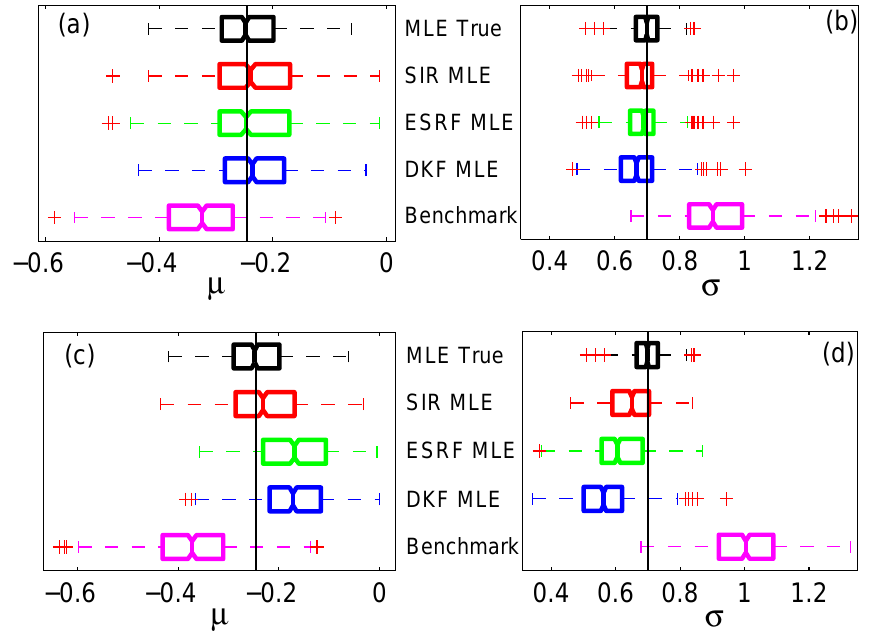
Fig. 10. Boxplot of the distributions of the parameters µ (left) and σ (right) estimated using the “true” event times, the SIR filter, the EnSRF, the DKF and the benchmark. (a) and (b) uniformly distributed observational errors. (c) and (d) Gaussian mixture distributed observational errors. Each boxplot shows the median and its 95% confidence intervals (notches). The boxes mark the 25th and 75th percentile (the interquartile range) of the empirical distribution. The whiskers mark 1.5 times the interquartile range and the red pluses mark outliers beyond this